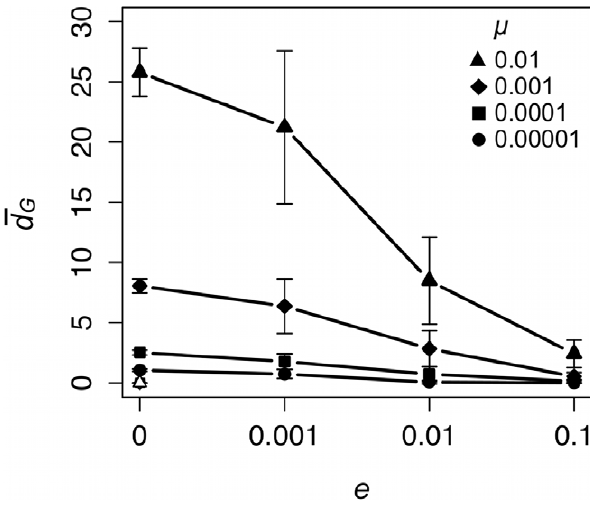
Figure 6. Local extinction rate ( e ) affects group differentiation as measured by (cid:2) dd G . Each data point provides the mean 6 1 standard deviation of 20 unique simulated populations. Black symbols represent data collected from populations with unbiased cultural transmission and white symbols data collected from populations with conformist cultural